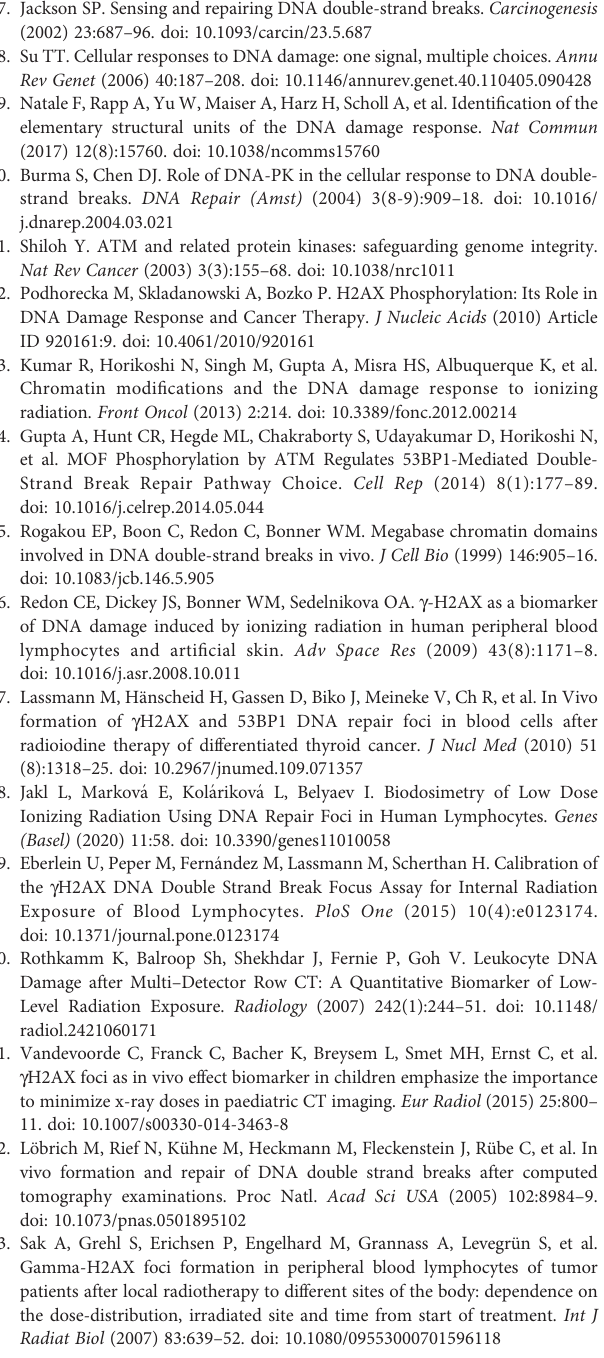
Supplementary Figure 8 | Cellular senescence-associated beta-galactosidase (SA- b